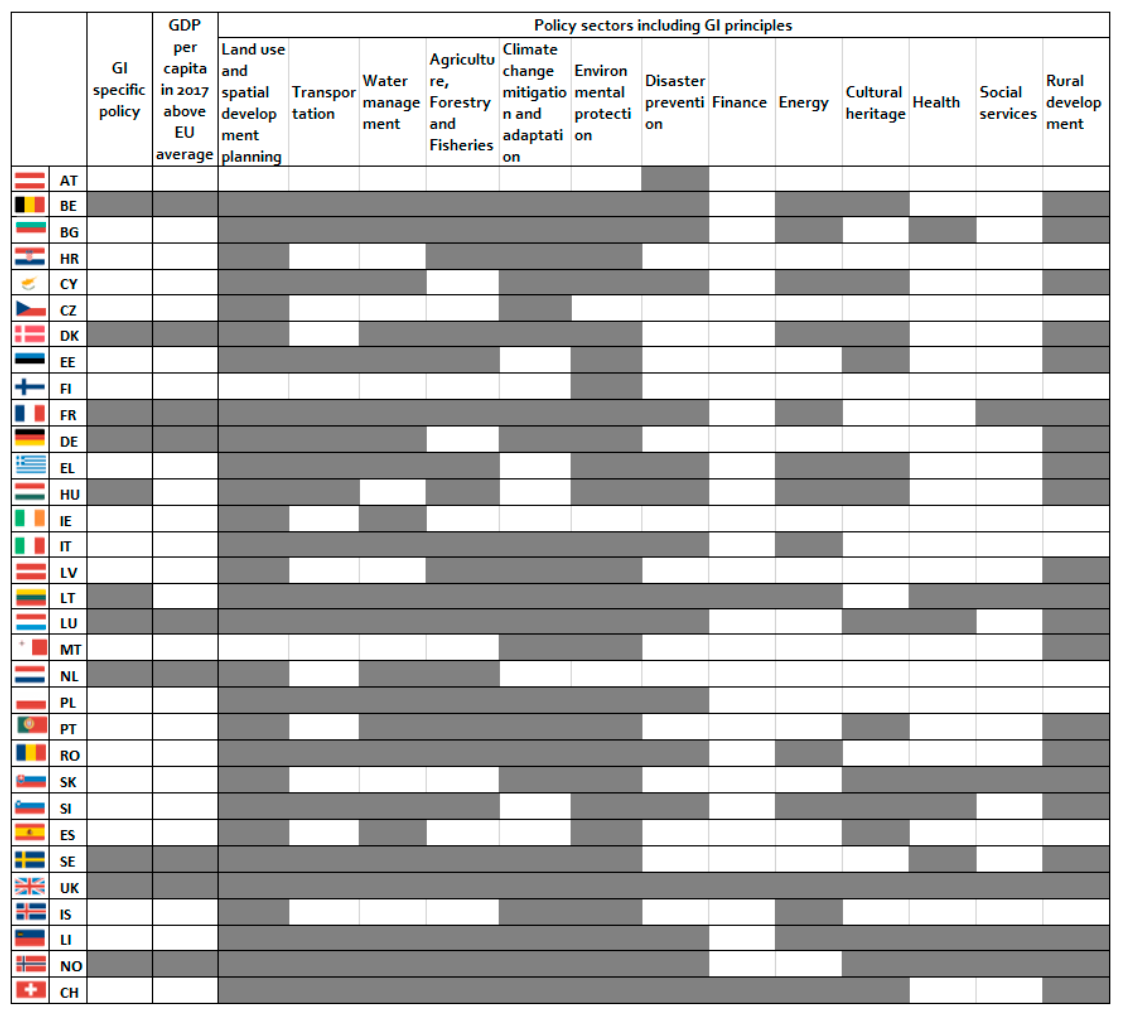
Figure 1. Green infrastructure in policy sectors in 32 European countries (EU28 and Iceland, Liechtenstein, Norway and Switzerland). Based on a summary of 41 survey responses, e-mail and phone correspondences, face-to-face interactions and document analysis. The filled boxes indicate “yes”, and the white boxes indicate